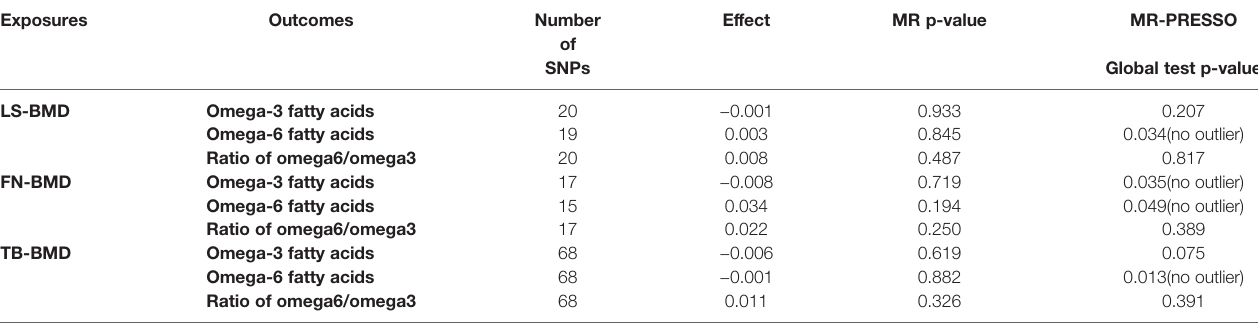
TABLE 5 | MR-PRESSO estimates of the causal effects of BMD on